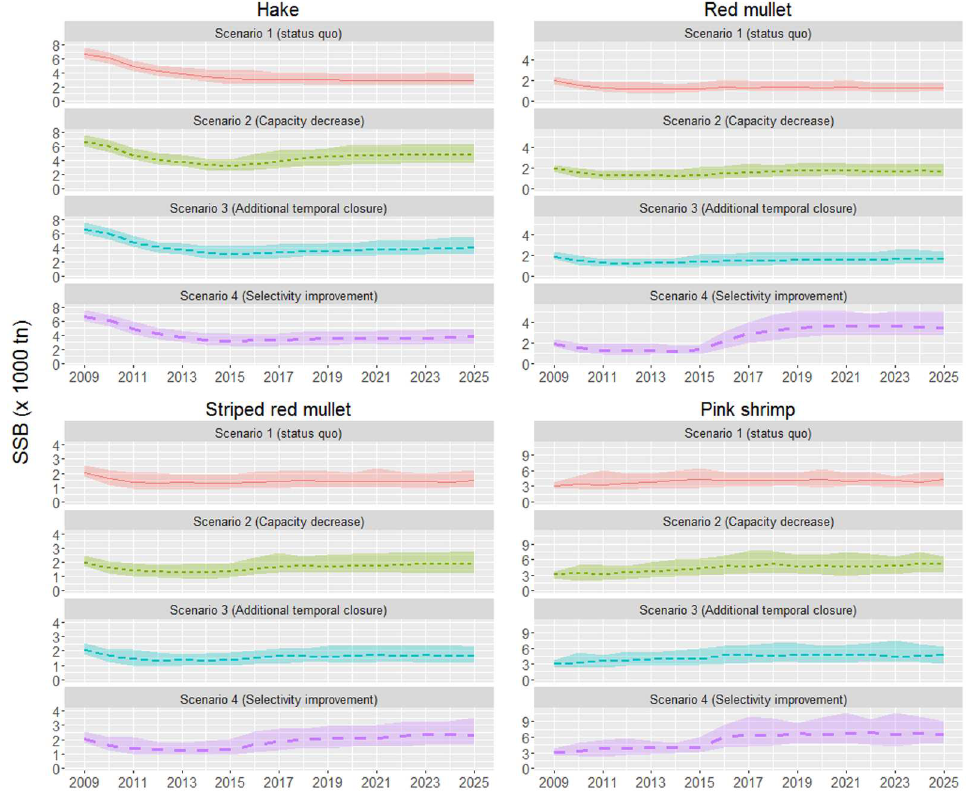
Fig 2. Spawning Stock Biomass by species (in 000’s tons) under the four simulated scenarios. Dotted lines indicate the medianestimates and the upper and lower limits of each ribbon represent the 0.1 and 0.9